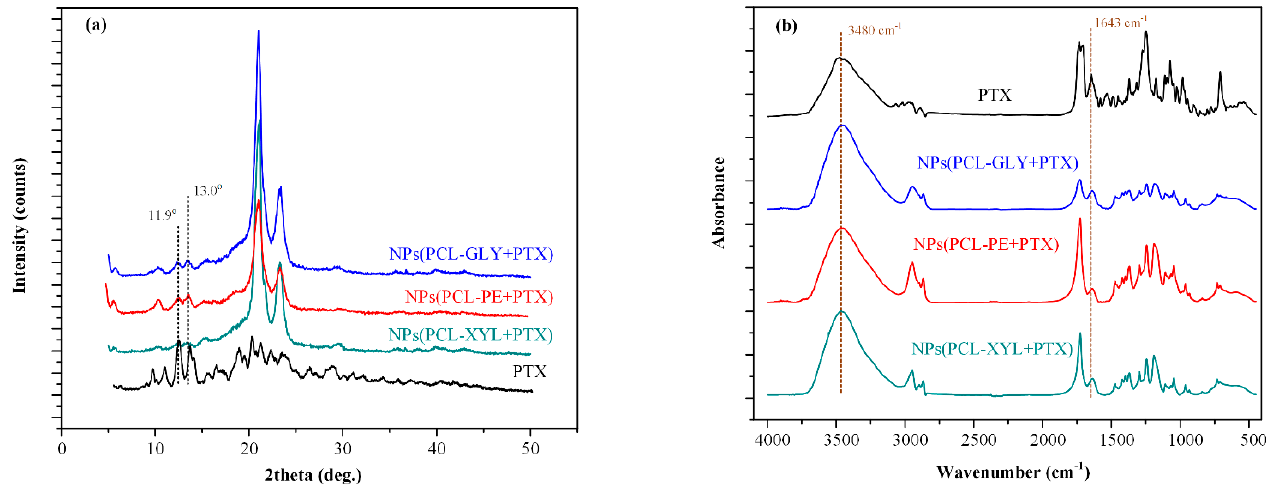
Figure 9. pXRD diffractograms ( a ) and FTIR spectra ( b ) of the PTX-loaded NPs prepared with the synthesized PCL branched copolymers.